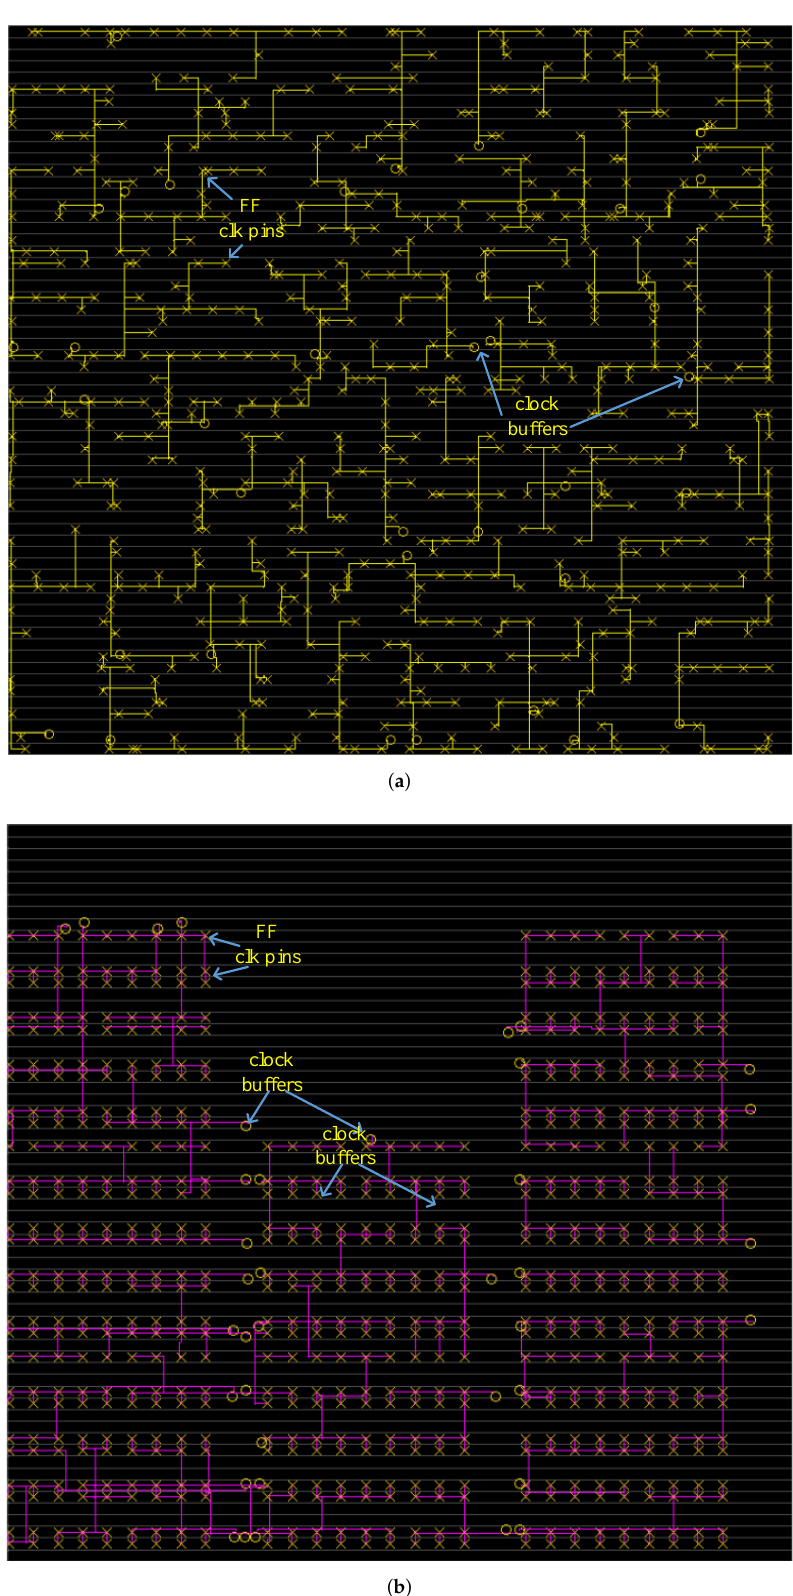
Figure 9. Clock Tree in both Normal and SDP Flow. ( a ) Normal Flow. ( b ) SDP